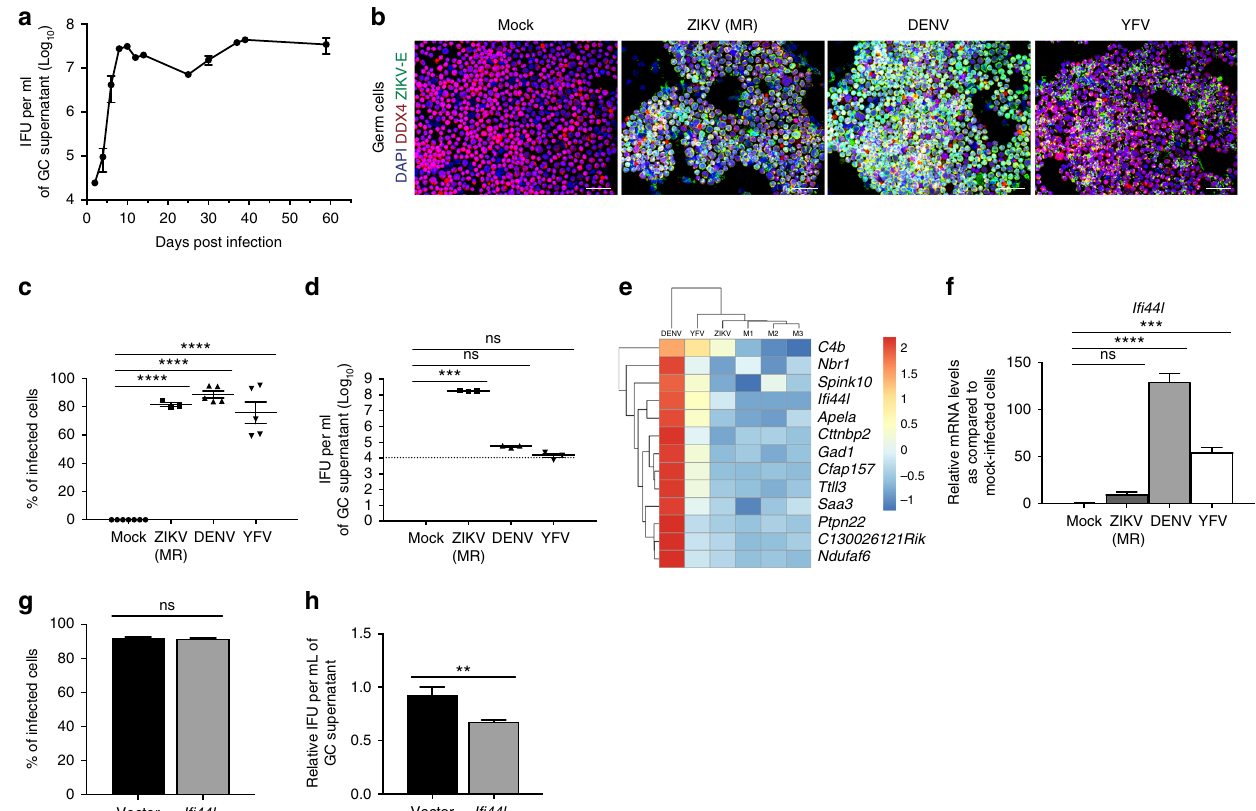
Fig. 4 Male GCs propagate ZIKV due to reduced I fi 44l activation. a Assessment of long-term propagation of ZIKV in GCs up to 59 dpi with an intracellular fl ow cytometry-based Vero assay. b – d Immunostaining ( b ), the quanti fi cation of Fig. 4b ( n = 7 for mock, n = 3 for ZIKV, and n = 5 for DENV and YFV) ( c ), and the quanti fi cation of infectious virus in the supernatant of male GCs infected by mock, ZIKV (MOI = 0.1 PFU per cell), DENV (MOI = 0.1 PFU per cell), and YFV (MOI = 0.1 PFU per cell) at 72 hpi ( d ). e Heatmap of differential expression pattern from RNA-seq data of mock-infected, ZIKV-infected, DENV- infected, and YFV-infected GC. f qRT-PCR analysis of I fi 44l mRNA levels in GCs infected with mock, ZIKV, DENV, and YFV at 72 hpi. g Percent of GC I fi 44l and GC Vector infected by ZIKV (MOI = 0.1 PFU per cell) at 72 hpi. h Infectivity analysis of supernatant from ZIKV-infected GC I fi 44l and GC Vector at 72 hpi with intracellular fl ow cytometry-based Vero assay. The relative number was normalized to IFU ml − 1 of supernatant of GC Vector at 72 hpi ( n = 14 for GC vector and GC I fi 44l ). n = 3 for all experiments except where indicated; data are presented as mean ± s.e.m.; two-sided t test for g , h ; one-way ANOVA for c , d , f ; ** p ≤ 0.01, *** p ≤ 0.001, **** p ≤ 0.0001, or no signi fi cance (ns). In d , the gray dashed line represents the limit of detection. ZIKV strain is MR 766